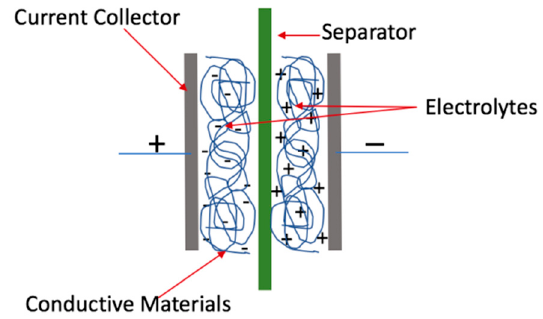
Figure 1. A typical electrical double-layer capacitor.